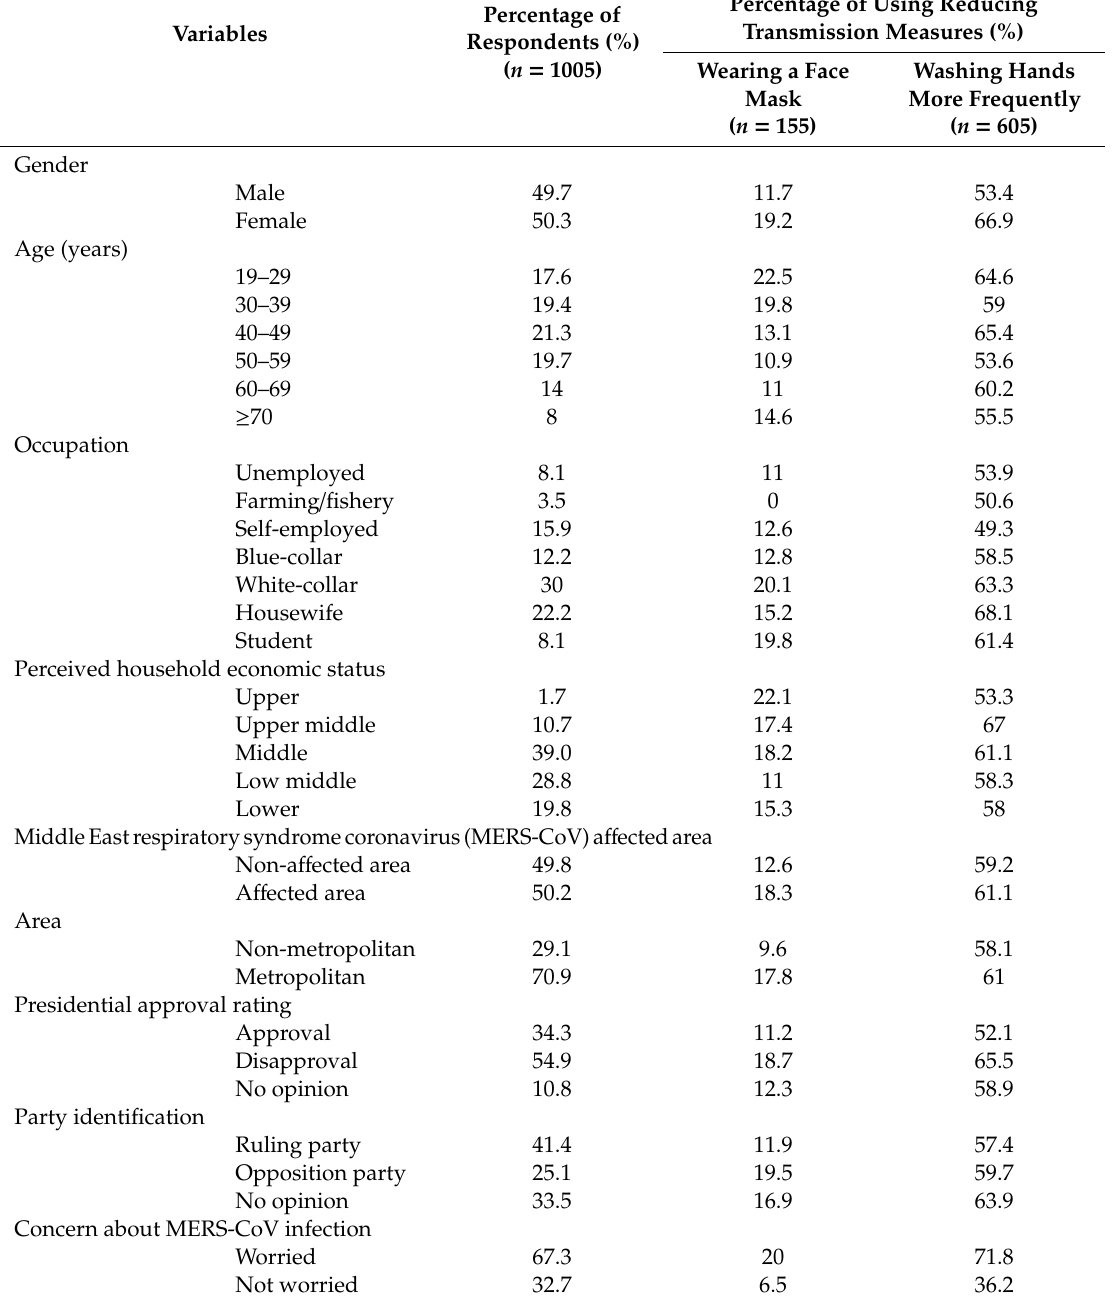
Table 1. General characteristics of the respondents and use of reducing transmission measures (Survey